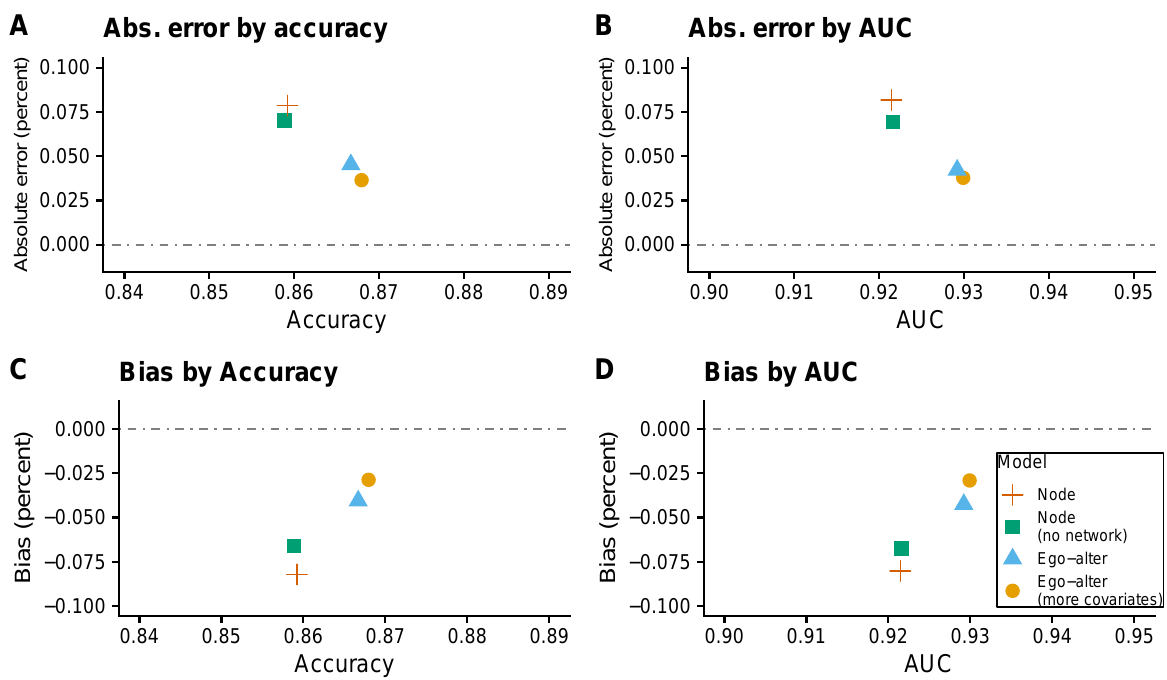
Figure 6: Models with similar node-level classification performance produce different levels of absolute error and bias when estimating homophily using proportional-to-degree sampling. In ( C ), the best model in terms of homophily bias (ego–alter with additional controls; gold) has an average bias of about –2.5 percent and a node-level classification accuracy of 86.7 percent. The worst model in terms of homophily bias (node model; red) has an average bias of about –7.5 percent and a node-level classification accuracy of 85.9 percent. A degradation in classification accuracy of 0.8 percent is associated with tripling the bias when estimating homophily. Although this plot shows results for sampling proportional to degree, results are similar for node and edge sampling and extend to the additional performance metrics of precision and